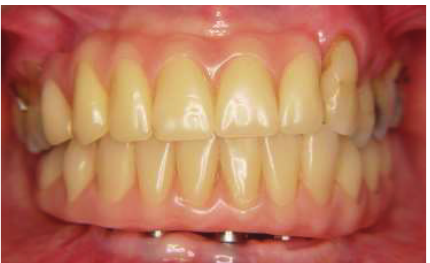
Figure 9: Clinical aspect of the prosthesis after 12